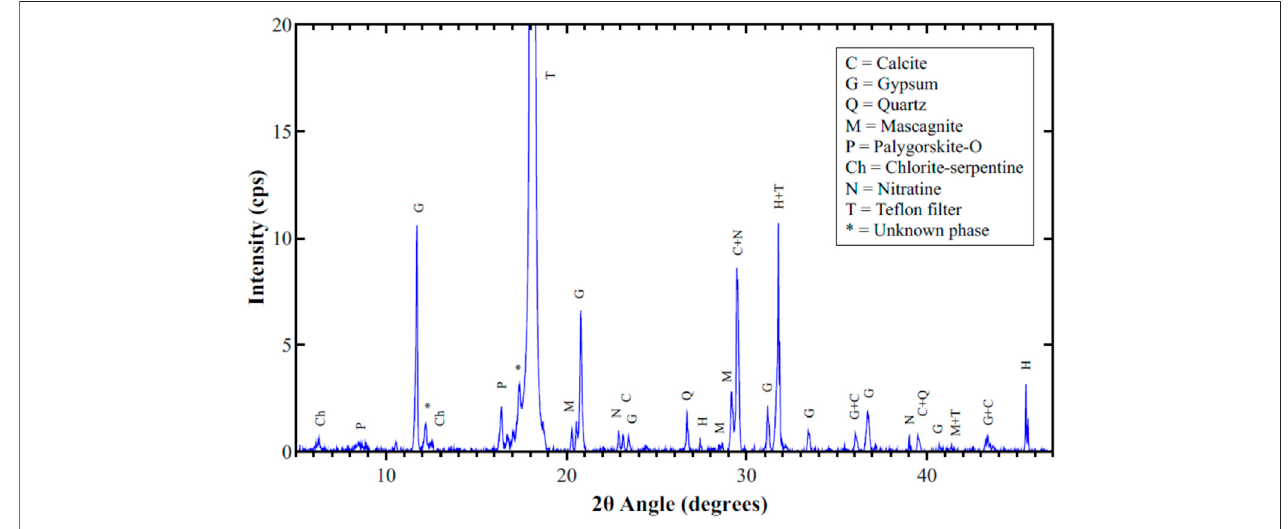
FIGURE 6 | XRD pattern of sample # 3 collected on January 28, 3018.